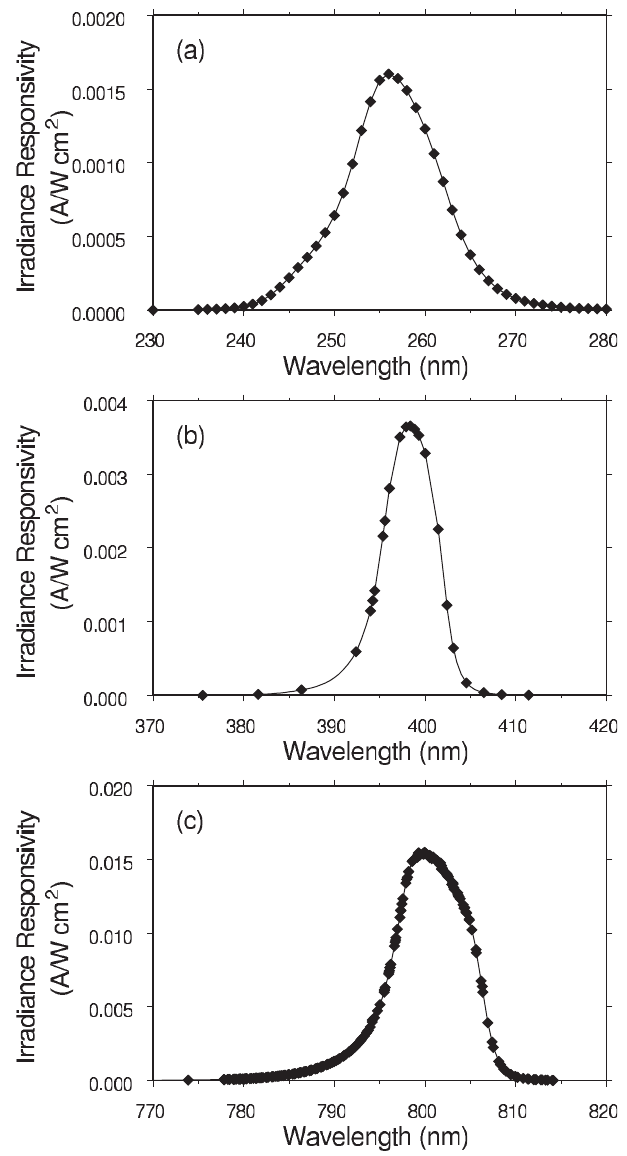
FIG. 5. Measured irradiance responsivities of filter radiometers with (a) FR1, (b) FR2, and (c) FR3.